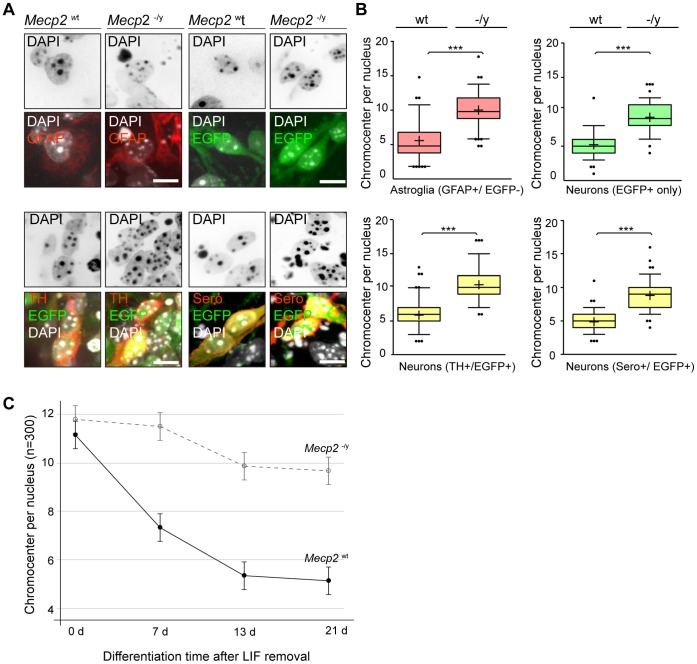

Mecp2 deficient neurons and astroglia cells have significantly more chromocenters than wild type cells.A. Representative confocal microscopy optical sections of differentiated Mecp2 wild type and Mecp2 deficient nuclei revealed characteristic differences in heterochromatin organization. Positive immunostaining for the astroglial marker GFAP (upper left) or for neuronal markers TH (lower left) and serotonin (lower right) indicated a differentiated cell state. In addition, the population of EGFP-only positive neurons was analyzed (upper right). Bar: 10 µm. B. Compared to wild type cells Mecp2
−/y tEG nuclei (n = 100 each) revealed significantly more chromocenters, here visualized in whisker-box plots. Median values are shown as horizontal lines within the box, whiskers represent the 5–95 percentile, mean values are indicated as crosses, and outliers are visualized as dots. All analyzed samples show a highly significant (p<0.0001) difference of mean values. GFAP+/EGFP− wild type cells revealed an average chromocenter number of 5.8±2.4 compared to 10.2±2.3 chromocenters in Mecp2
−/y tEG cells. The mean chromocenter number per nucleus in TH+/EGFP−
Mecp2 wild type cells was 5.9±2.0 versus 10.4±2.3 chromocenters in Mecp2 deficient cells. In Sero+/EGFP+ wild type cells we found on average 4.9±1.4 chromocenter versus 9.3±2.0 chromocenters per nucleus in Mecp2 deficient cells. The EGFP+ only population, showing 5.4±2.0 chromocenters in Mecp2 wild type cells and 10.1±2.2 chromocenters in Mecp2
−/y tEG cells, mirrored these tendencies. C. Unbiased analysis of data from three biological replicates (n = 100 per data set) for Mecp2 wild type (solid line) and Mecp2 deficient (dashed line) cells at different time points revealed significant decrease of chromocenters within the first two weeks of differentiation whereas extended differentiation time to 21 days did not result in further large scale heterochromatin remodeling. Error bars: 95% confidence intervals according to the mixed linear model.